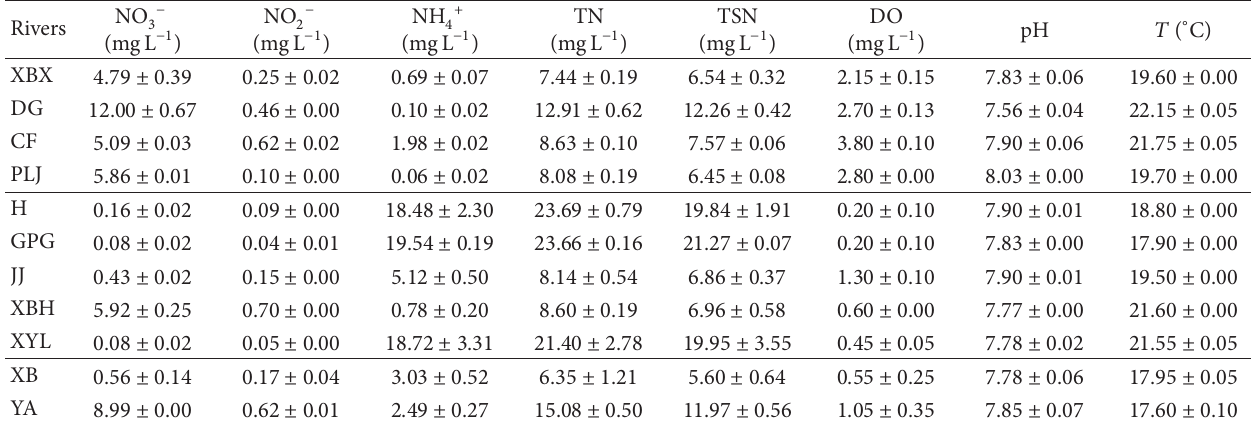
Table 2: Water properties of the rivers at Dianchi Lake (mean ± SD).